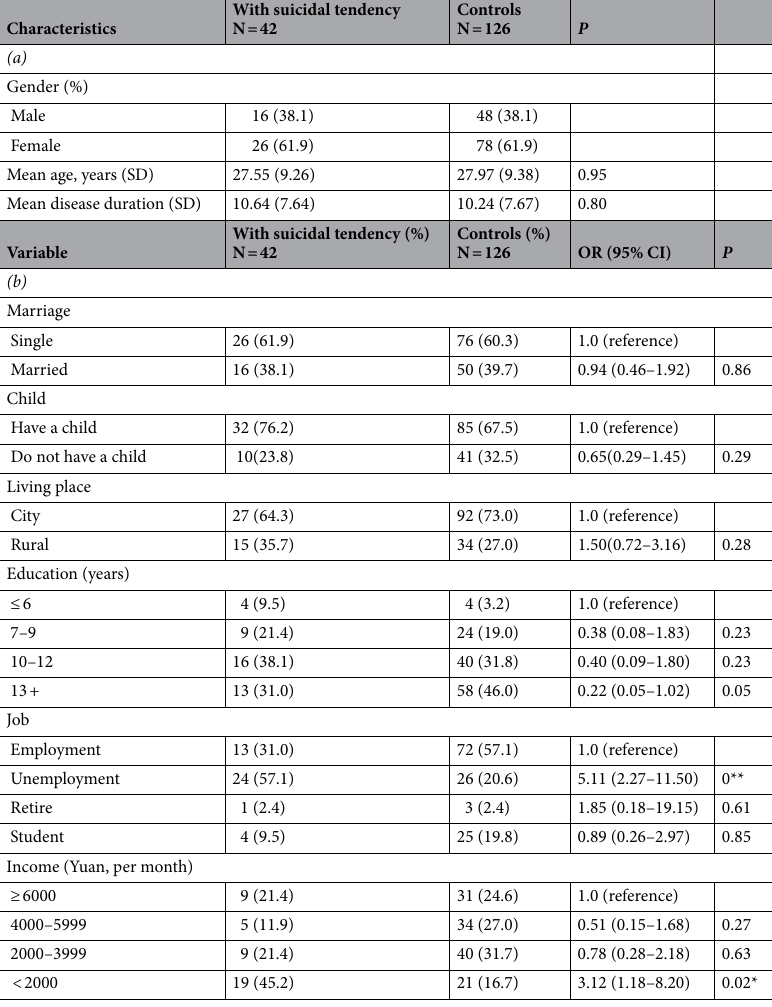
Table 1. (a) Comparison of Baseline characteristics for cases and controls (b) Comparison of sociodemographic characteristics between PWE with high suicidal tendency and PWE without (Result of using univariable analysis). CI confidence interval, OR odds ratio. * P < 0.05; ** P <